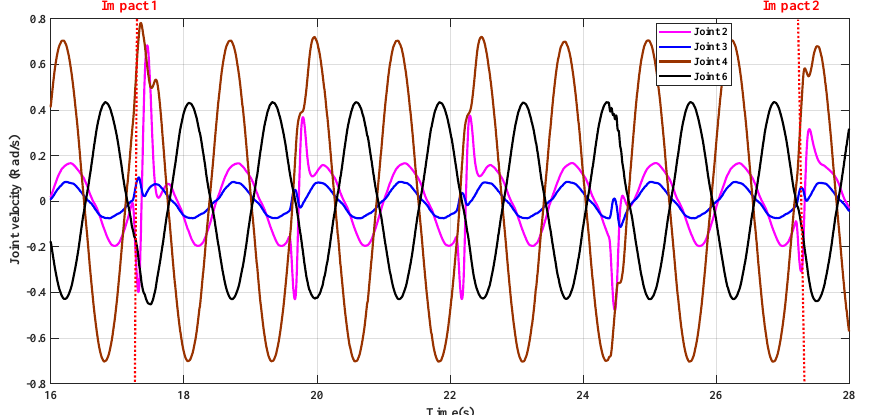
Figure 11. The angular velocities of joint 2, joint 3, joint 4 and joint 6 during trajectory running, where two dynamic collision time points are marked with red dashed